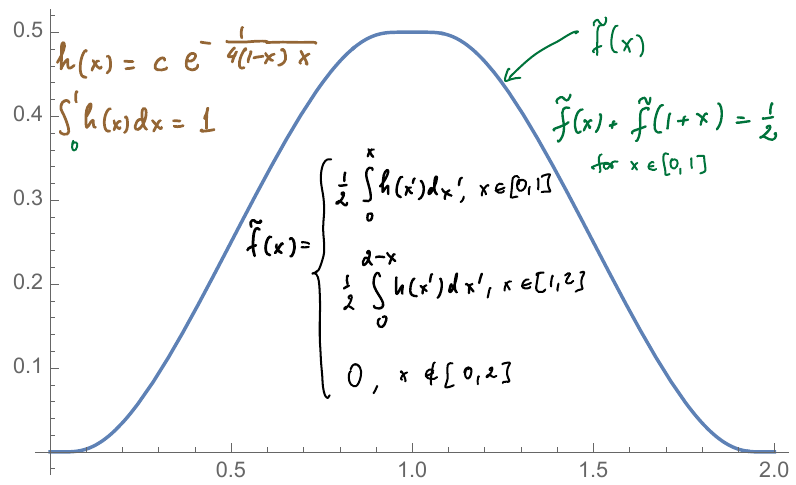
˜ f ( x ) , vanishing outside x ∈ [0 , 2] and